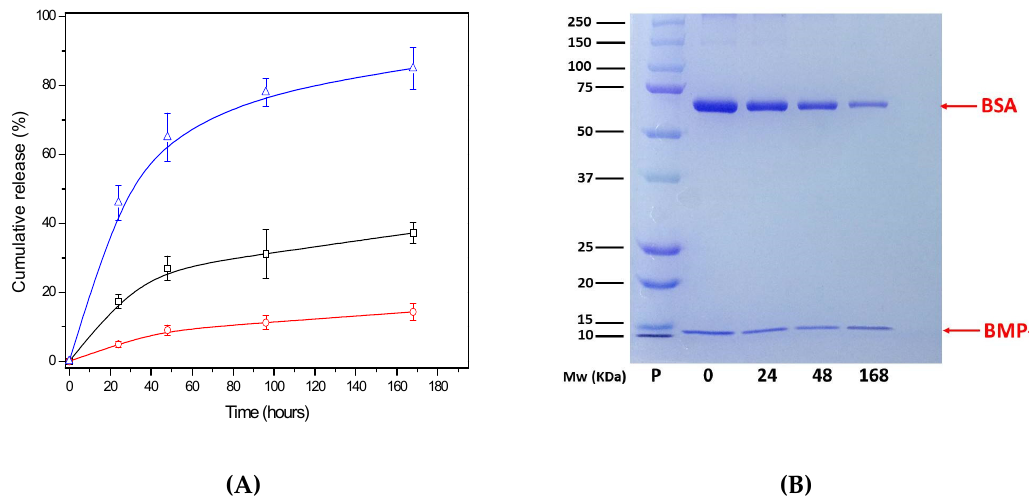
Figure 5. ( A ) Cumulative release of rhBMP-2 for NP-BMP2 (black square) and NP-BSA-BMP2 (red circle) systems; and cumulative release of BSA for NP-BSA-BMP2 (blue triangle) system, incubated for different times at 37 °C in saline phosphate buffer (pH 7.4). ( B ) SDS-PAGE analysis under reducing conditions of solid fraction of NP-BSA-BMP2 after release at di ff erent times where the number of each lane corresponds to the time in